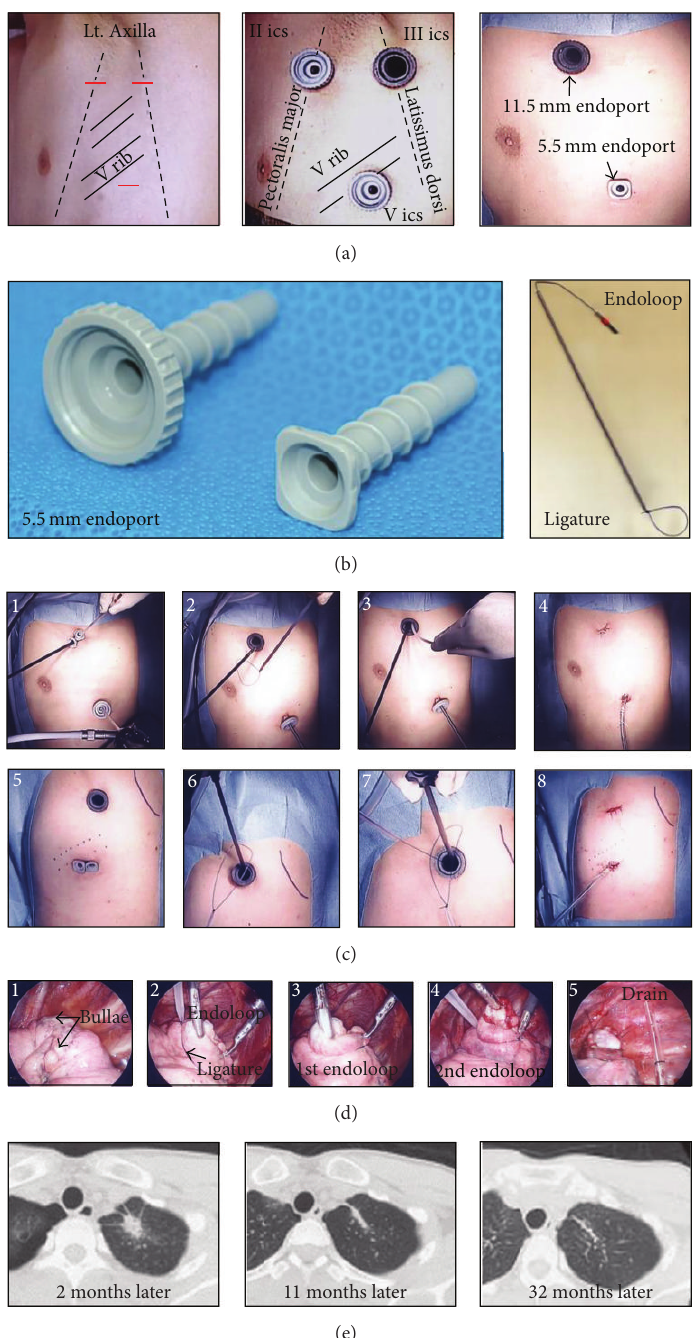
Figure 3: Schematic of the thoracoscopic endoloop ligation procedure. (a) Thoracoscopic ports placed on the anterior axillary line in the second intercostal space and midaxillary line in the fifth intercostal space. (b) Surgical instruments. (c) External view of the operative procedure images. (d) Thoracoscopic view of the procedure. (e) CT scan images at 2, 11, and 32 months after a successful